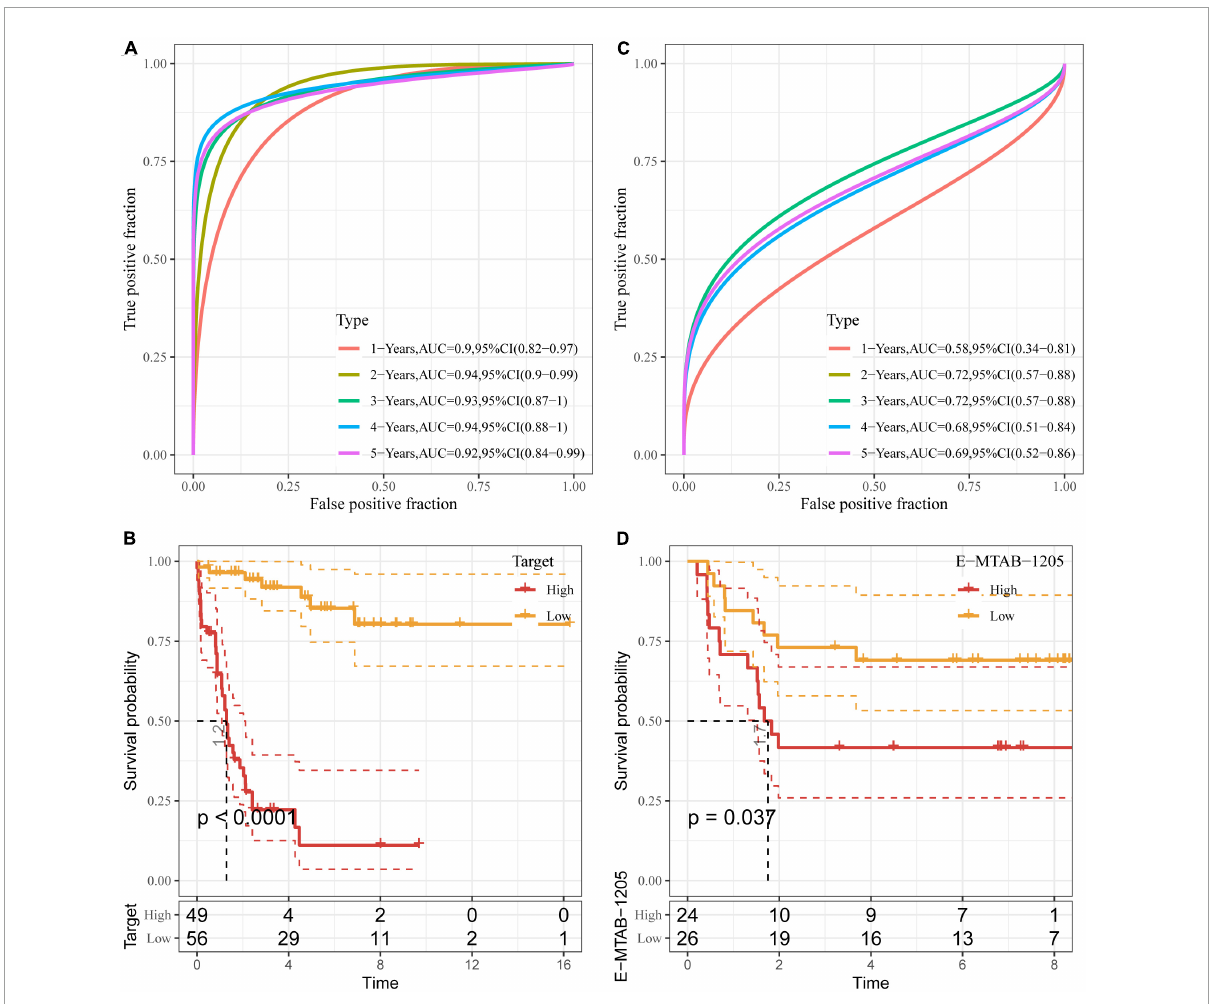
FIGURE5 Validation of DAMPs-related risk model. (A,B) ROC curve (A) and K – M survival curve (B) of risk model constructed by seven genes in Target dataset; (C,D) ROC curve (C) and K–M survival (D) of risk model constructed by seven genes in E-MTAB-1205